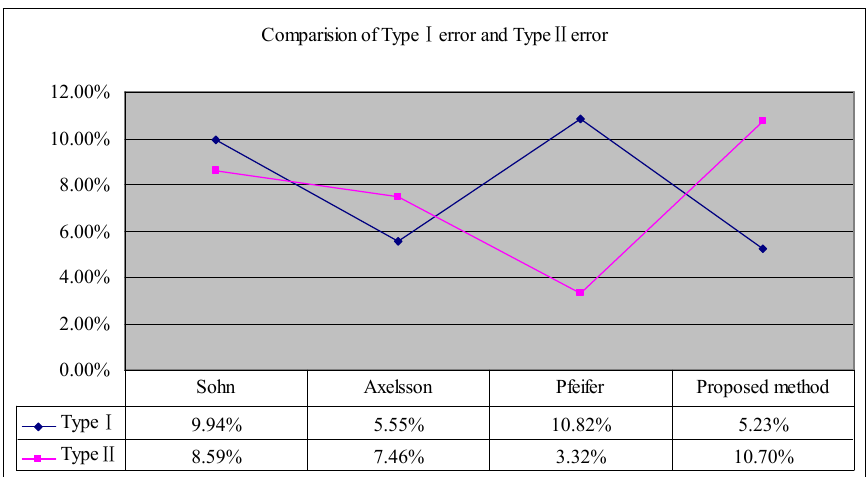
Figure 6. Comparison of average overall accuracy of the different filtering algorithms.